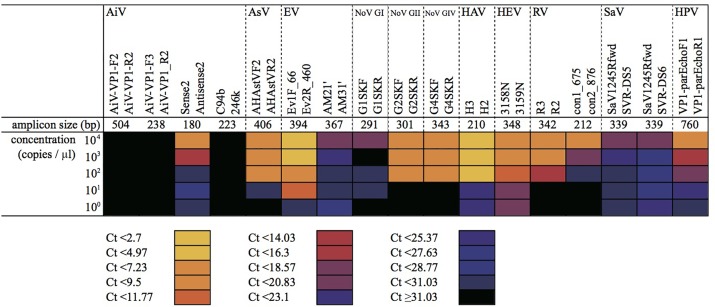
Detection of serially diluted virus samples by microfluidic nested PCR followed by MiSeq amplicon sequencing. Plasmid DNA and cDNA samples containing target regions of each virus were mixed at equimolar concentrations and diluted to 104–100 copies/μL. The mixtures were subjected to the first round of MF-PCR, and the amplicon was collected and used for MFnPCR with 20 oligonucleotide primer sets for detection of 11 viruses (i.e., AiV; AsV; EV; NoV GI, GII, and GIV; HAV; HEV; RV; SaV; and HPV). CT values determined in the nested MF PCR are shown as a heat map. Amplicon size represents the size of a PCR amplicon without an Illumina tag sequence.